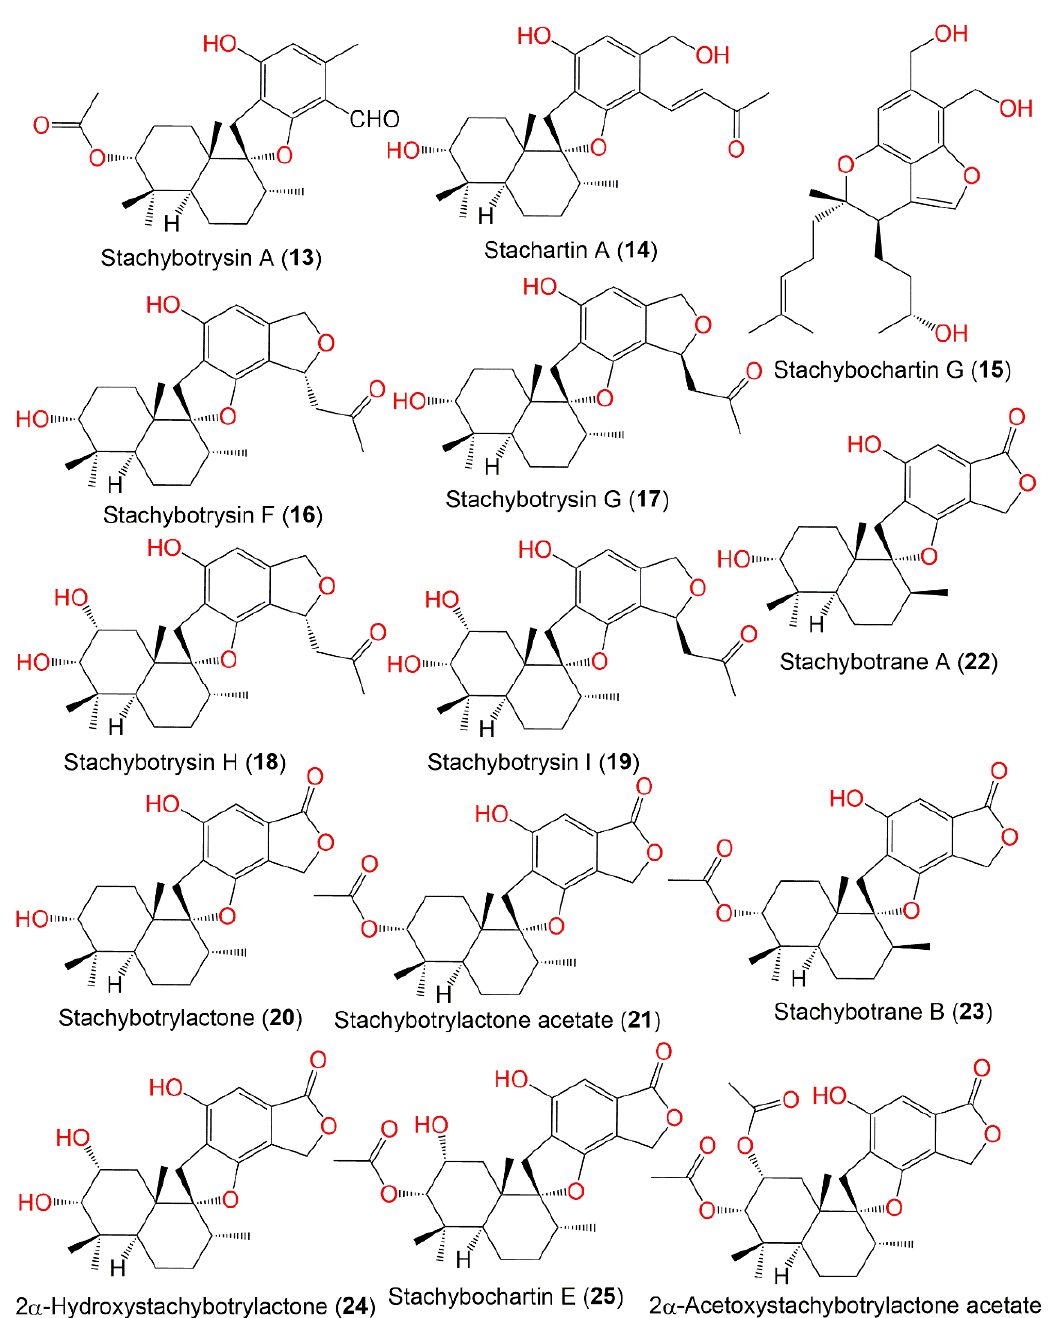
Figure 2. Structures of phenylspirodrimane derivatives ( 13 – 26 ) reported from S . chartarum .